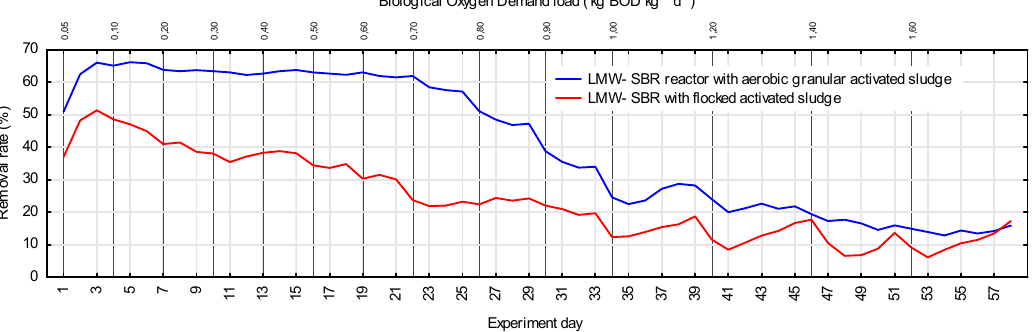
Figure 1. Sum of low molecular weight polycyclic aromatic hydrocarbons ( Σ LMW) removal rate in sequencing bath reactor (SBR) anaerobic phase.